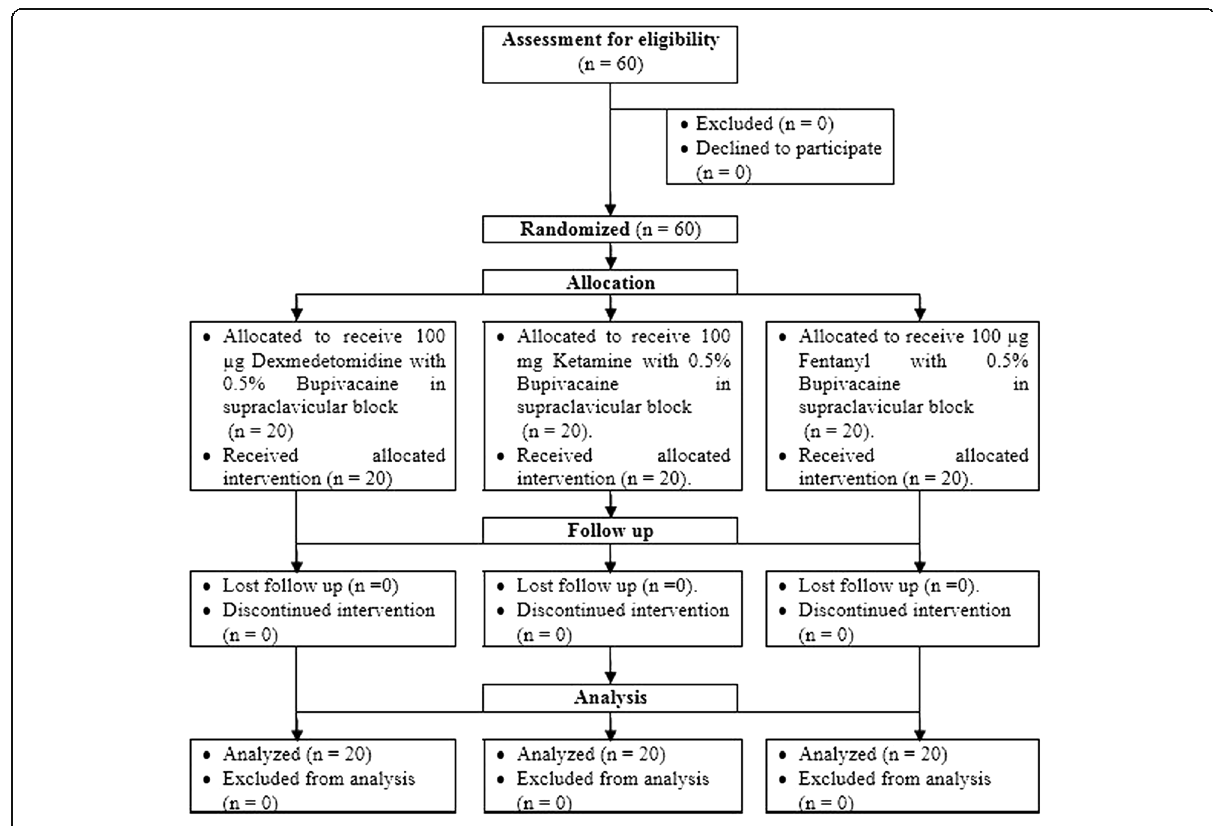
Fig. 1 CONSORT flow diagram showing number of patients at each phase of the study